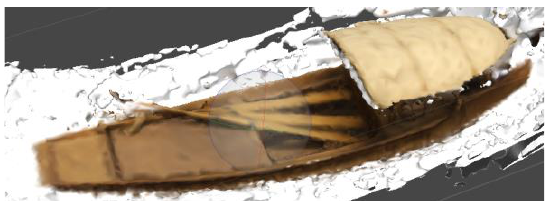
Figure 7b. Small Junk Model creating using DLSR Images and Agisoft Metashape